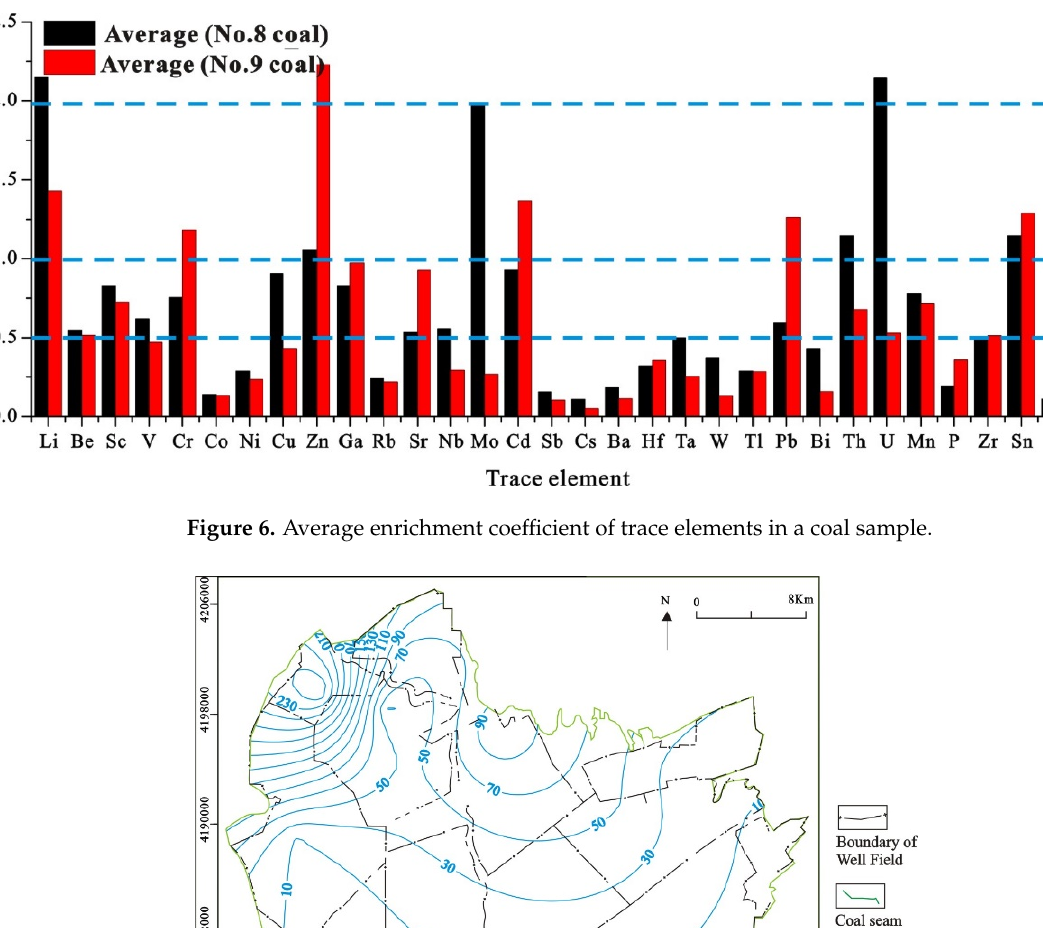
Figure 8. Average element content ratio of No. 8 coal and No. 9 coal. 4.4. Rare Earth Element The total content of REY in No. 8 coal ranges from 17.65 to 98.51 µg/g, with an average of 60.74 µg/g. The content in the Baijiazhuang, Ximing, and Malan well fields are relatively low, and the content in the Tunlan, Duerping, and Dongqu well fields is relatively high (Figure 9). The total content of REY in No. 9 coal ranges from 41.93 to 165.80 µg/g, with an average of 75.55 µg/g, which is higher than that of No. 8 coal, similar to the distribution of No. 8 coal. The Dongqu well field has the highest content (165.80 µg/g), and it gradually decreases toward the west and east (Figure 10). The average content of REY in both coals are lower than that of Chinese coal (138 µg/g) [38] (Dai et al., 2016) (Table 7).